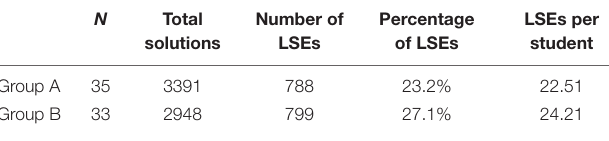
TABLE 2 | Comparison of two groups’